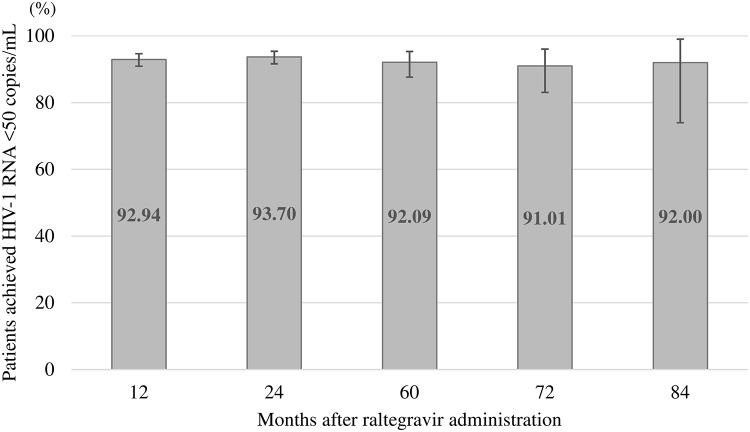
Proportion of patients with <50 copies/mL of HIV-1 RNA in patients treated with raltegravir.Error bars indicate 95% confidence intervals.